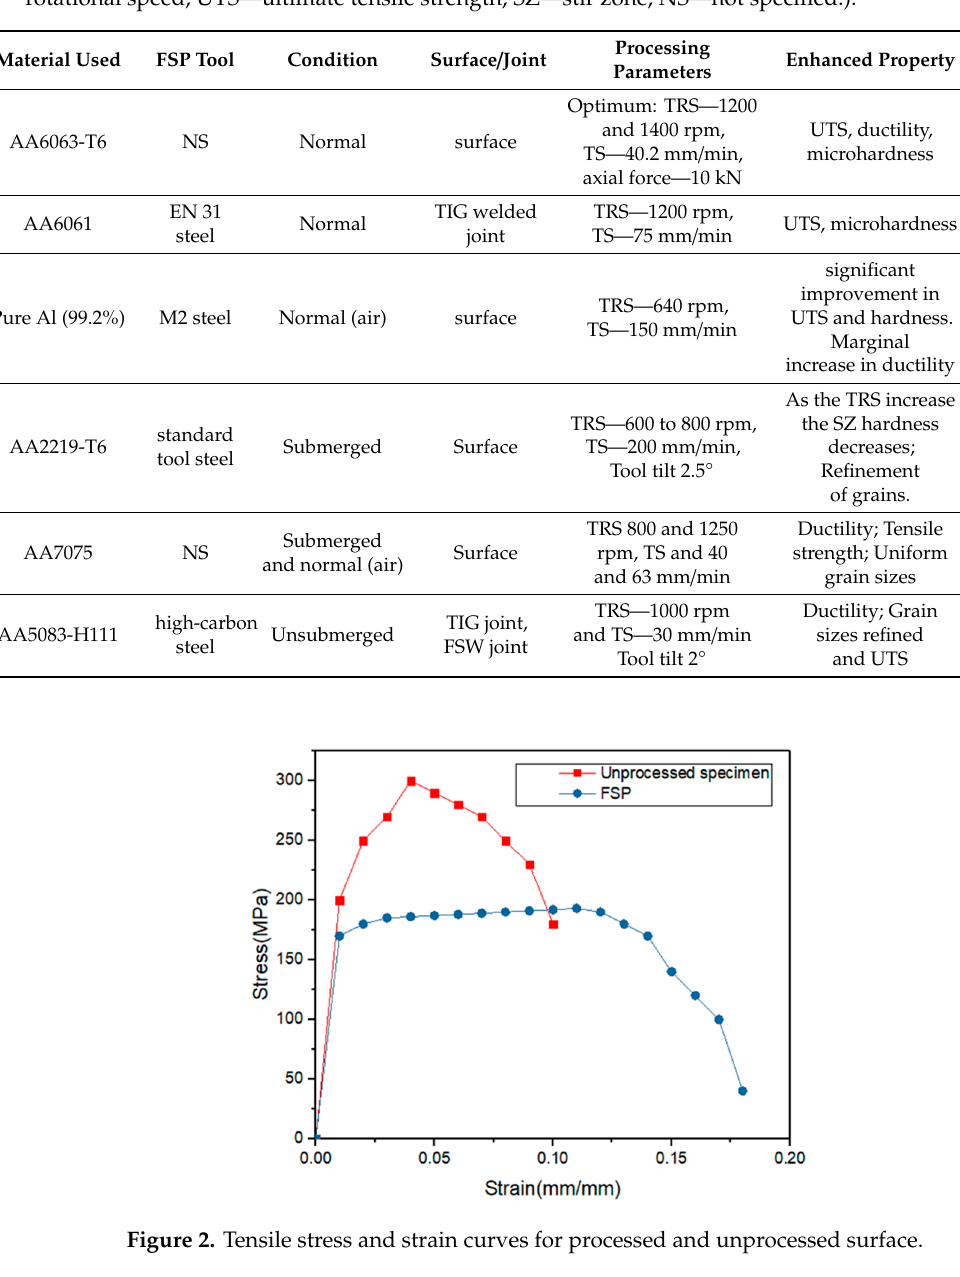
Table 3. Typical results of friction stir processed plate and joints. (TS—traverse speed, RTS—tool